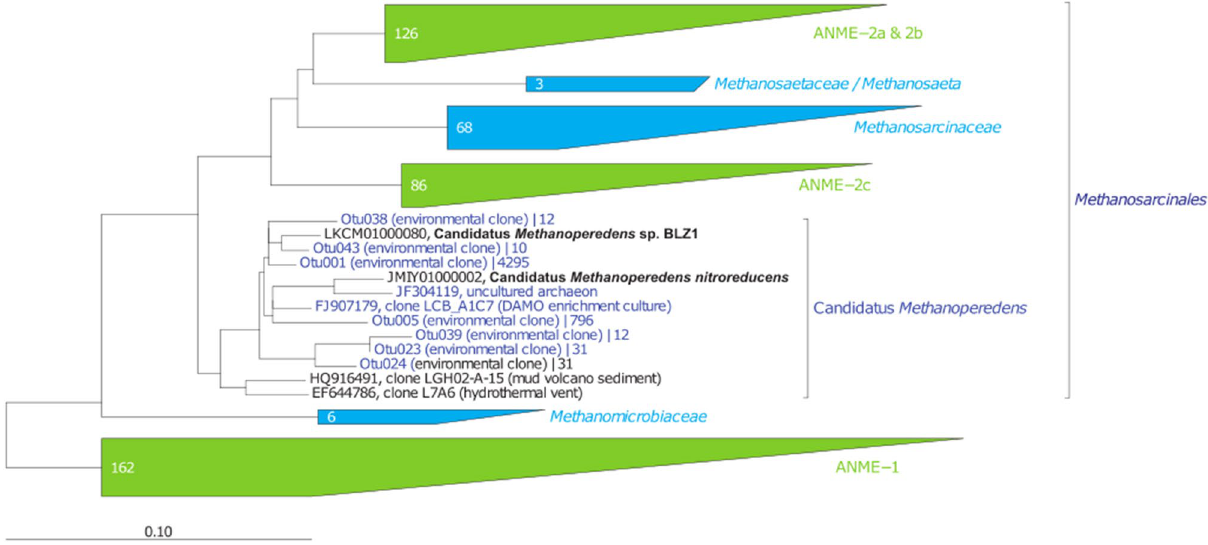
Figure 3. Presence of Candidatus Methanoperedens , capable of Fe-related AOM. 16S rRNA gene phylogenetic tree of the Candidatus Methanoperedens representative related OTUs (0.03 cut-off; only those OTUs containing more than 10 reads are shown) retrieved by pyrosequencing from Kabuno Bay water samples, the scale bar indicates 0.10 fixed point mutation per nucleotide